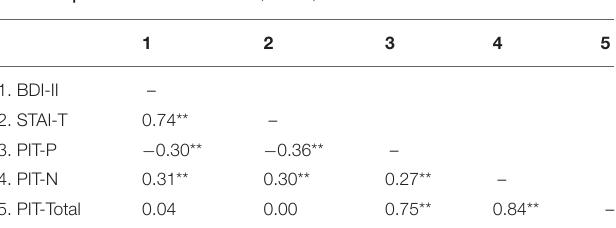
TABLE 3 | Correlation matrix of PIT, BDI-II, and STAI-T.